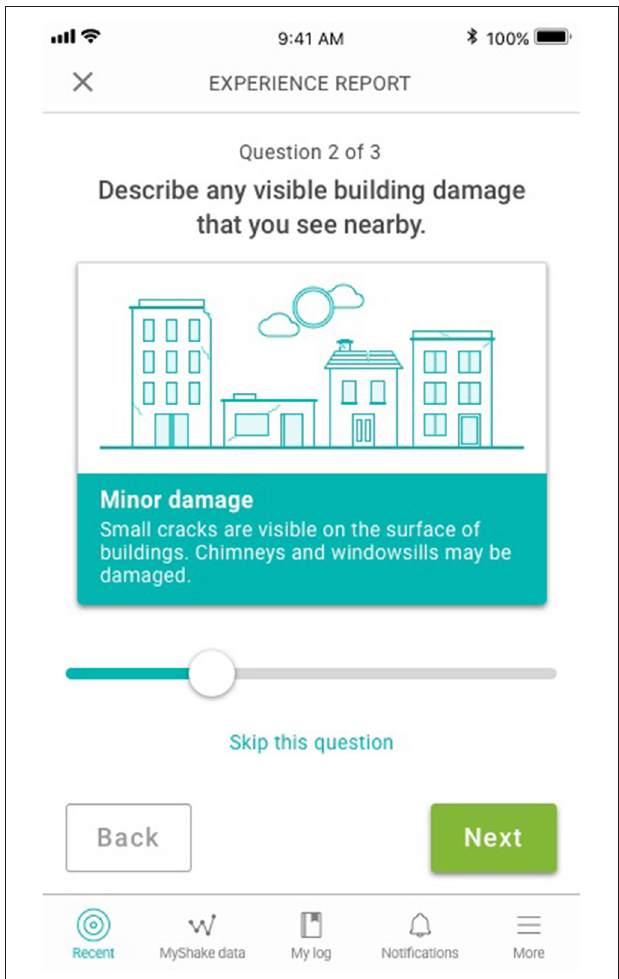
FIGURE 8 | My Data page where users can visualize their contributions to the MyShake project and the reach of the project as a